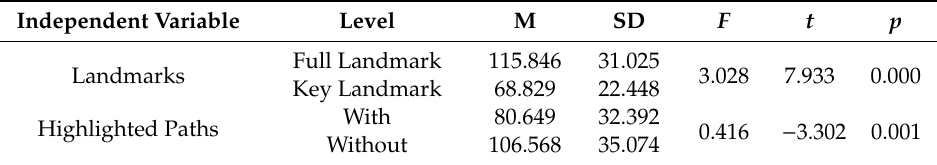
Table 1. Independent Sample t Test of task time.